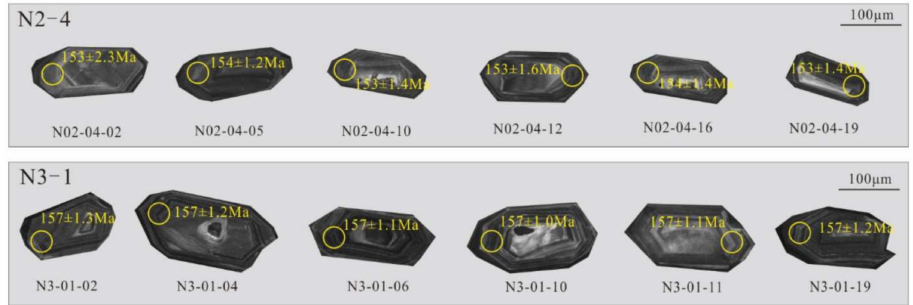
Figure 4. Cathodoluminescence (CL) images of the Nianzigou